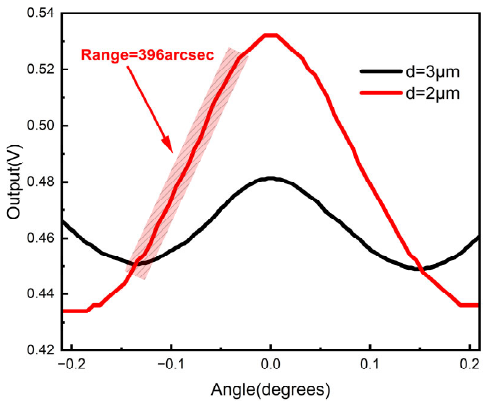
Figure 10. The output of the photodetector with d = 2 μ m and 3 μ m. In the 2 μ m ‐ period case, a linear range was obtained within a range from 0.04° to 0.15°, as shown in Figure 11. An error within ± 6 mV was obtained in the experiment. A slope of 0.68 V/degree and a standard deviation of 0.0093 V/degree were obtained by the linear fitting of the average experimental values. The sensitivity ( k 0 ) in an absolute unit (mV/arcsec) of the linear region was calculated to be about | − 0.68 V/degree| = 0.68 V/3600 arcsec = 0.19 mV/arcsec. The relative sensitivity ( k 1 ) could be given by